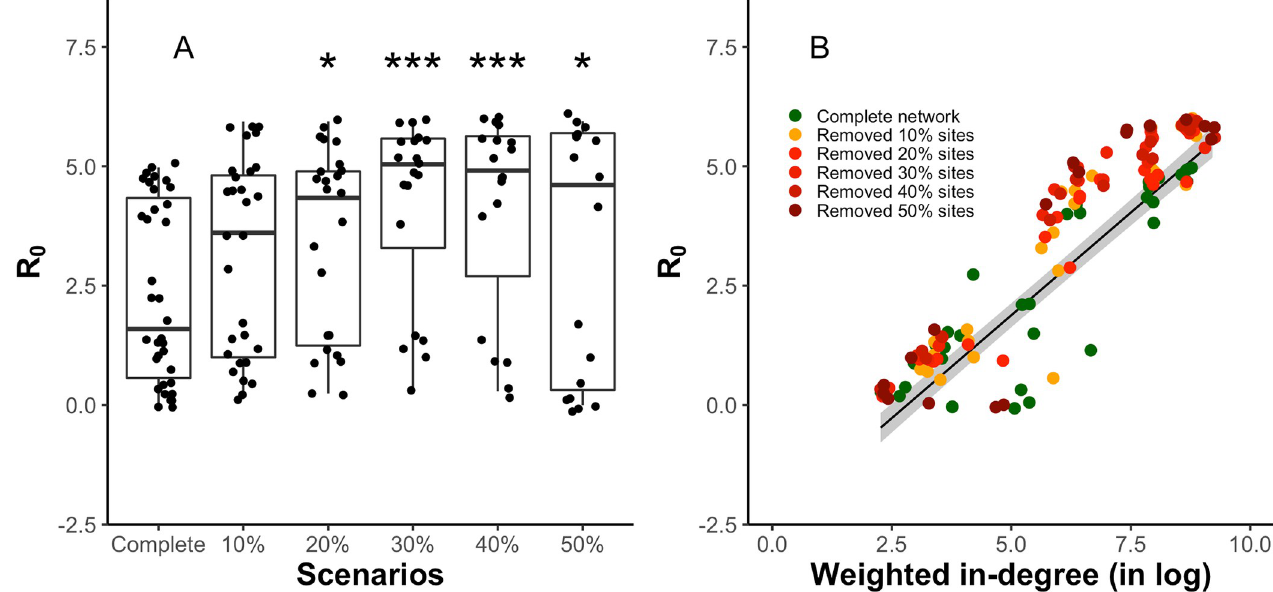
Fig 3. The effects of A) increasing sites removal and B) weighted in-degree on the basic reproduction number R 0 at each site. A) x-axis labels are the scenario of the complete network, and network scenarios of 10%, 20%, 30%, 40% and 50% removal of sites; B) black line represents the GLM fit, and grey shaded area represent the 95% confidence interval. The asterisk represents the levels of statistical difference ( � for p < 0.05, and ��� for p < 0.001), compared to the complete network scenario. Colored dots are the maximum R 0 values generated by agent-based model simulations under different network scenarios.